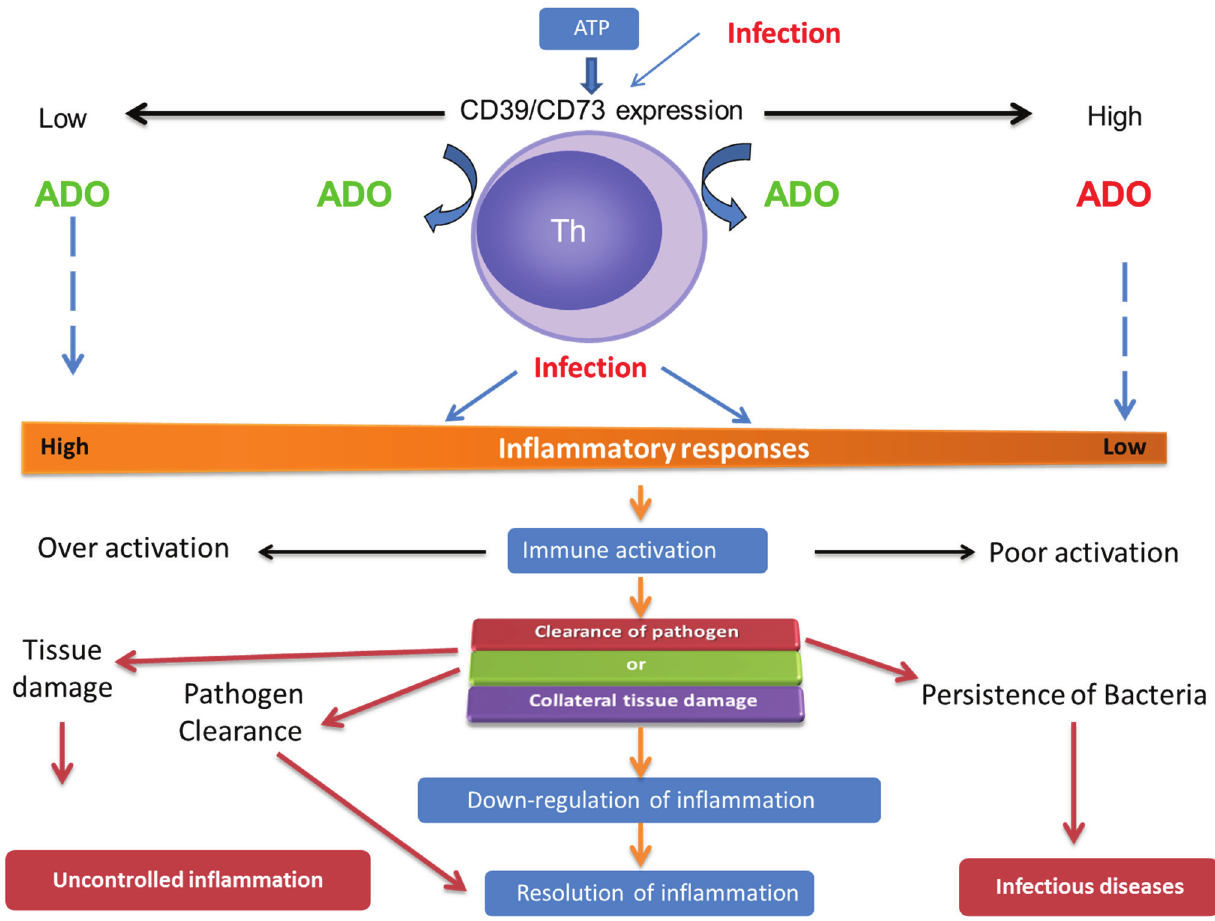
Figure 1. ATP is catabolized by CD39/CD73 expressed in immune cells to generate extracellular adenosine that regulates the outcome of inflammatory response and pathogen persistence during infection. In the normal situation (center), infection-induced immune activation increases the extracellular adenosine level. When immune activation takes place in an adenosine-enriched environment (right side), effector functions of immune cells are insufficient to eliminate pathogens due to poor pro-inflammatory responses; therefore, outgrowth of infectious agents may result. Contrary to this, in the absence or reduced levels of CD39/CD73-Ado (left side), an increased inflammatory response may help the host to clear pathogens. At the same time, uncontrolled activation may lead to collateral tissue destruction. Any unregulated intervention to increase the expression of CD39/CD73 may dampen inflammation and impair immunity to